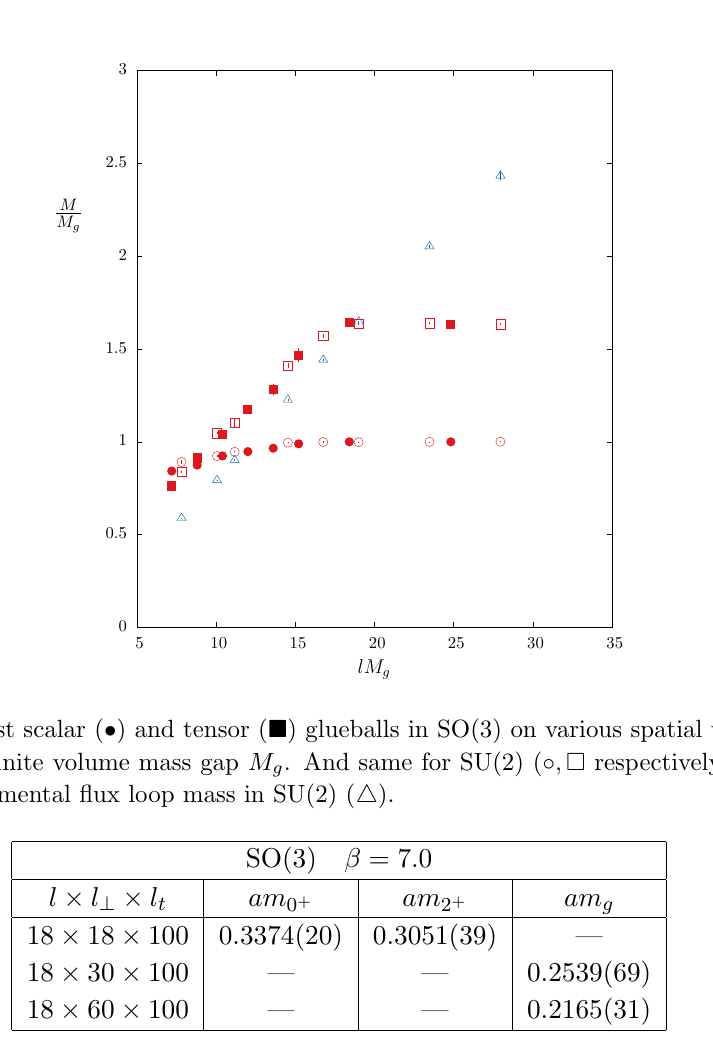
Table 6 . Lightest J P = 2 + ; 0 + glueball masses and the mass gap m g on various l x (cid:2) l y spatial lattice volumes. In SO(3) at an inverse bare coupling (cid:12) = 6 =ag 2 = 7 :